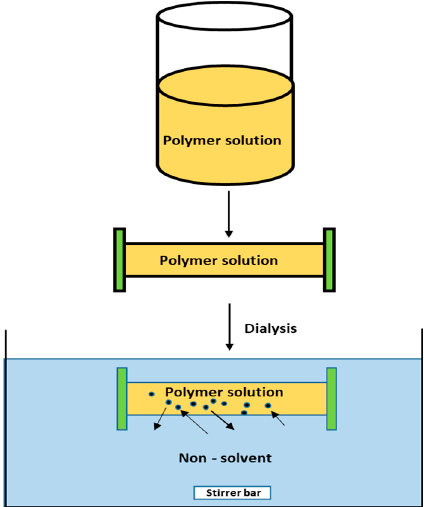
Figure 6. Schematic representation of an osmosis-based method for the preparation of polymer nanoparticles.